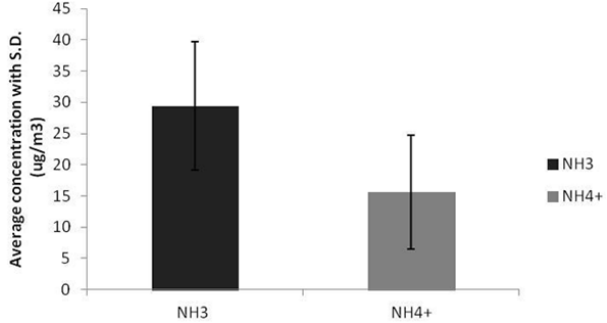
Fig. 3. Average concentration of gaseous NH 3 and particulate NH + Error bar shows standard deviation (S.D.) ( n = 91 for NH 3 and n = 72 for the NH + 4